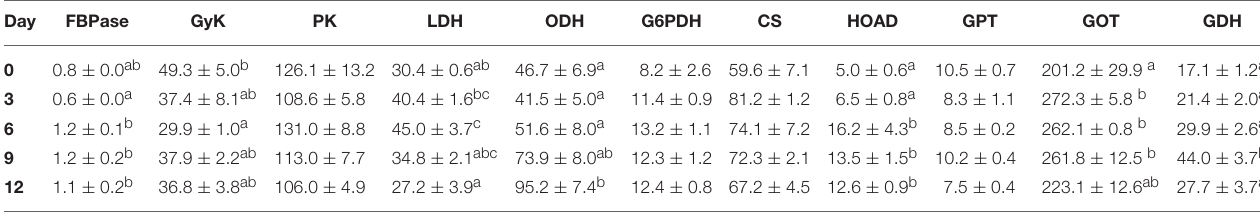
TABLE 2 | Ontogenic changes in the activity of key enzymes of intermediary metabolism in Octopus vulgaris palarvae. Day